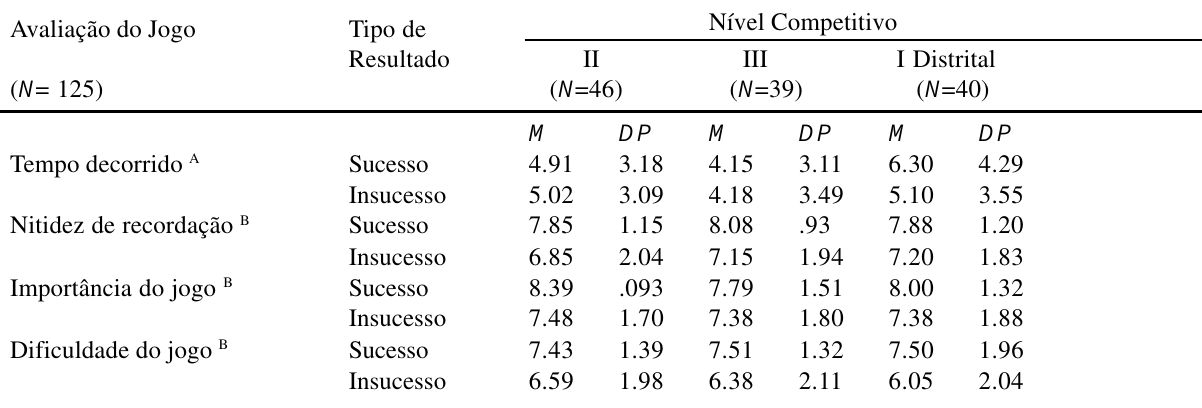
Avaliação do Jogo (Tempo Decorrido, Nitidez de Recordação, Importância e Dificuldade) em que Ocorreu o Resultado